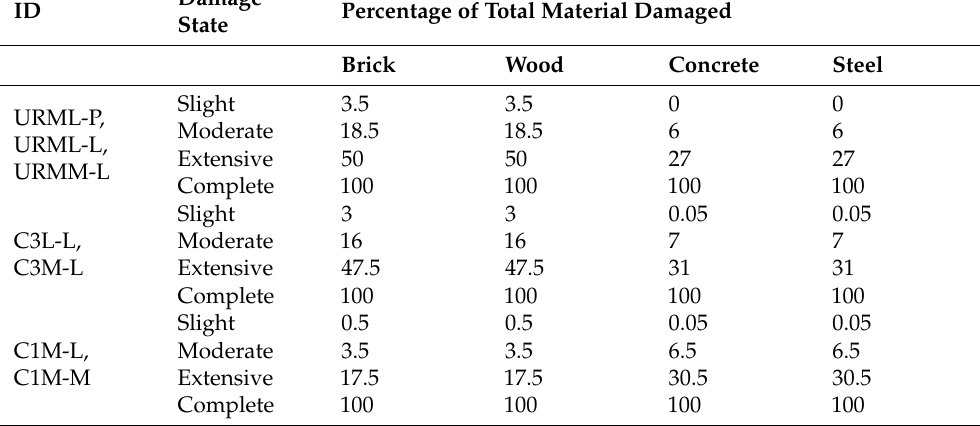
Table A4. Percentage of total material damaged given damage state for different building types.